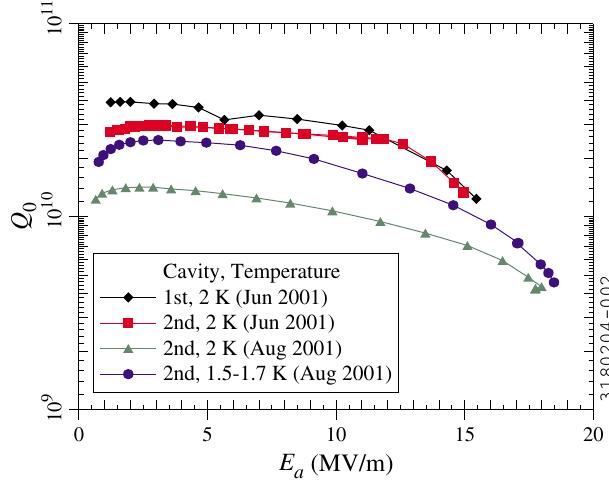
FIG. 3. (Color) Measured dependence of the quality factor on the accelerating gradient for the single-cell cavity